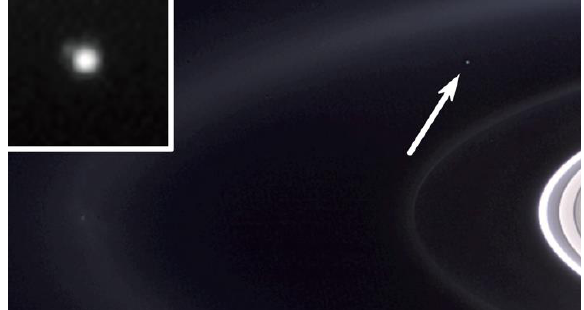
Figure 3. Photograph taken by the Cassini Orbiter spacecraft on September 15, 2006, at a distance of ~ 1.5 billion kilometers from Earth. The dot to the upper left of Saturn's rings, indicated by the arrow, is the Earth. Saturn was used to block the direct light from the Sun, otherwise the Earth could not have been imaged. Inset: expanded image of the Earth which shows a dim extension (the Moon). Credit: NASA.